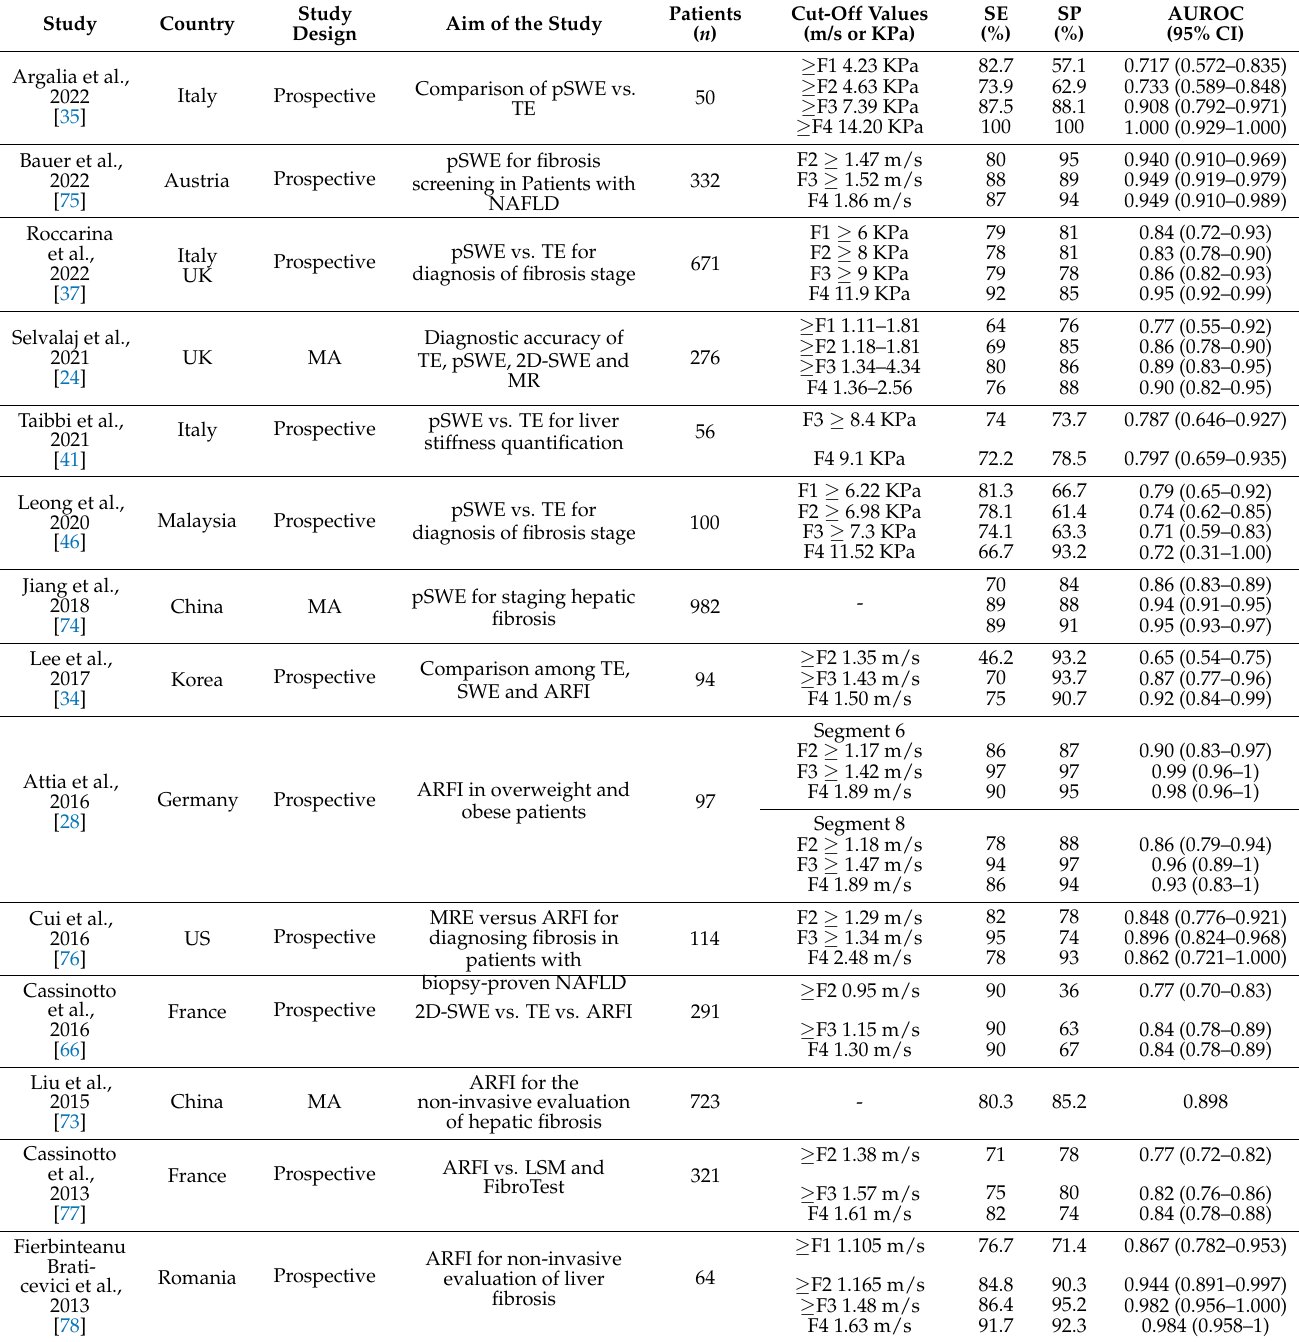
Table 2. Studies published in the last 10 years addressing the use of point shear wave elastography in NAFLD patients.